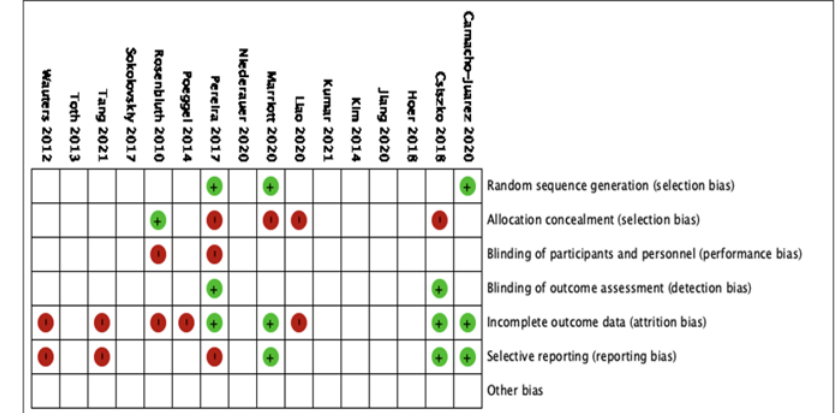
Figure 4. The risk of bias analysis of included studies.